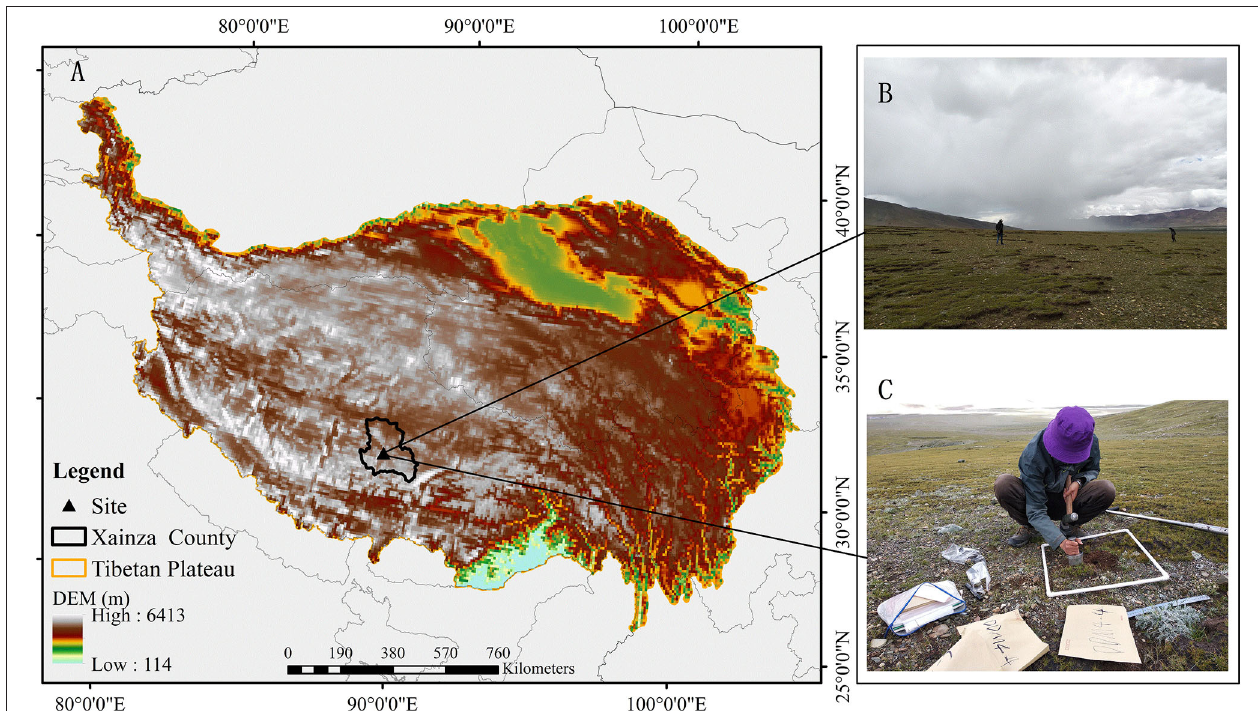
FIGURE 1 | The location of sampled sites in Xainza County on the Tibetan Plateau (A) . (B,C) presented the landscape of sampled site and sampled quadrat, respectively.